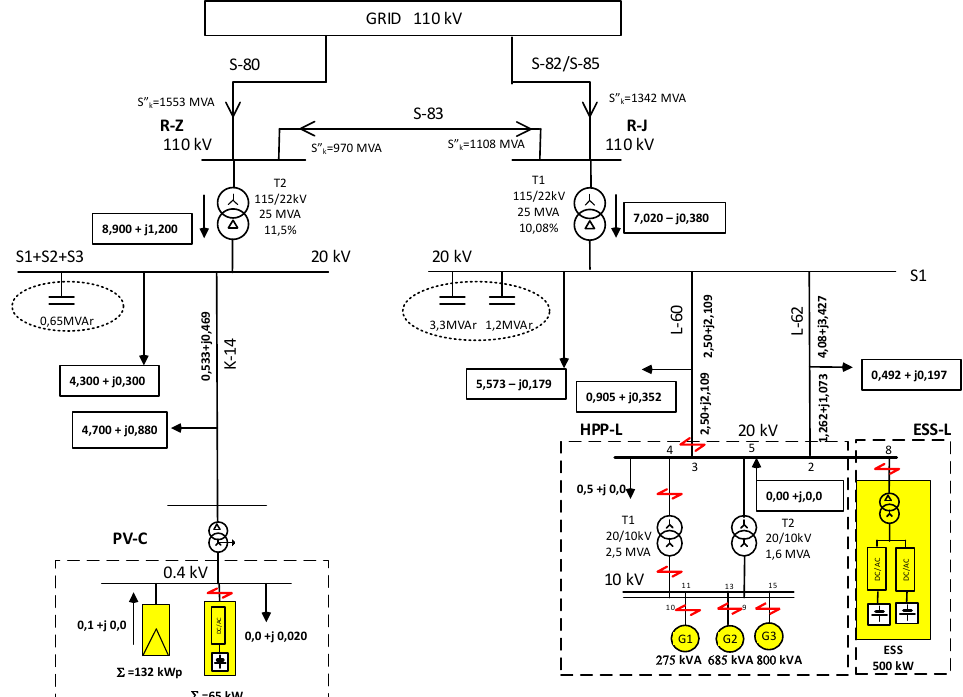
Figure 5. A simplified scheme of the electrical connection of the VPP, with denoted instantaneous power flow measurements at the time of the identified summer peak demand value.